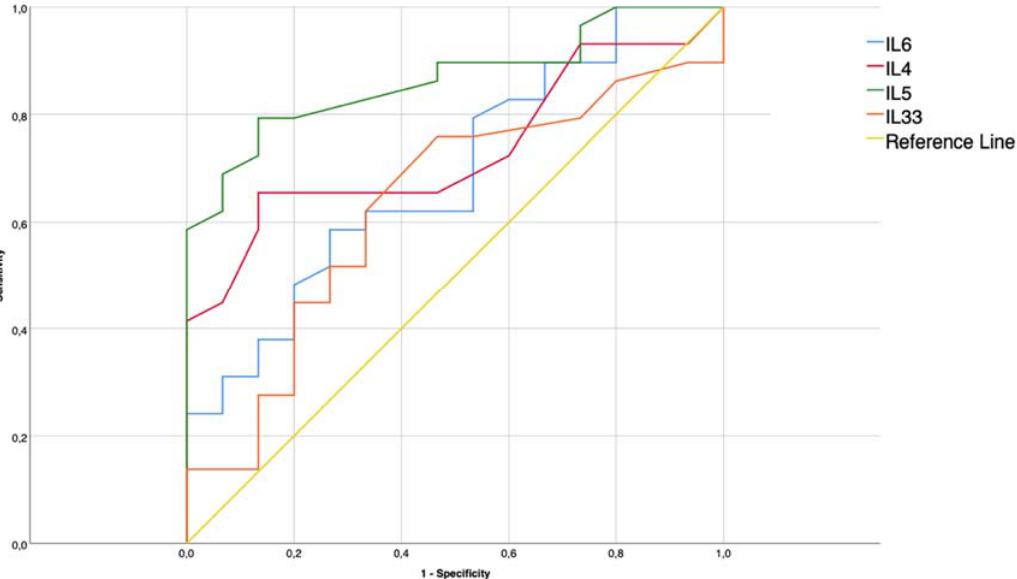
Figure 5. Results of ROC Analysis. ROC curves generated for IL-5, IL-4 IL-6, and IL-33 and reference line for AUC 0.5 shown for comparison. Marker on the IL-5 curve corresponds to the cut-off value of 2.3 ng/L at the coordinates of 93.3% sensibility and 70% specificity.